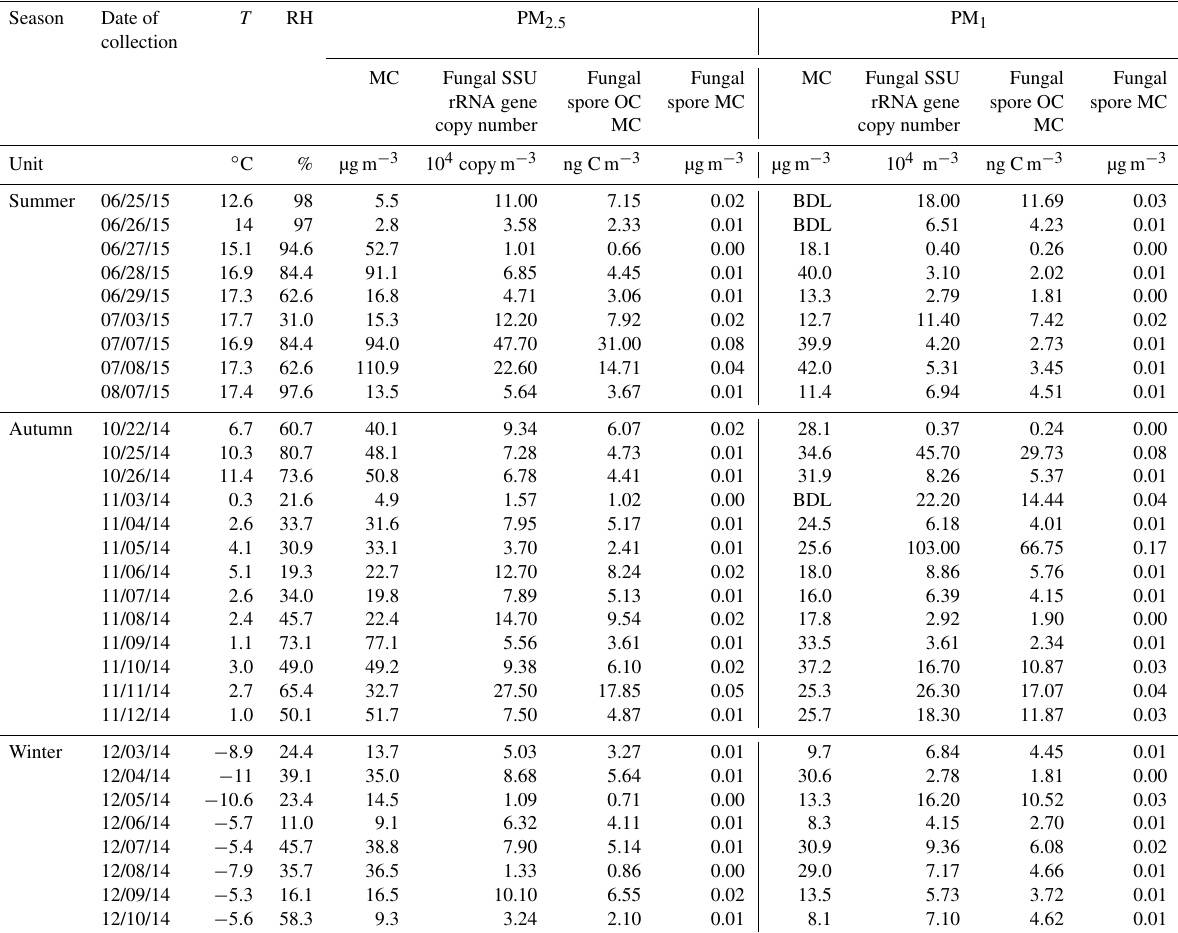
Table 1. Sample descriptions and the associated meteorological characteristics of the atmosphere, including the temperature ( T ), relative humidity (RH), PM 2 . 5 mass concentration (MC), PM 1 mass concentration, and fungal cell concentrations on the basis of qPCR analysis of rRNA copy numbers in PM 2 . 5 and PM 1